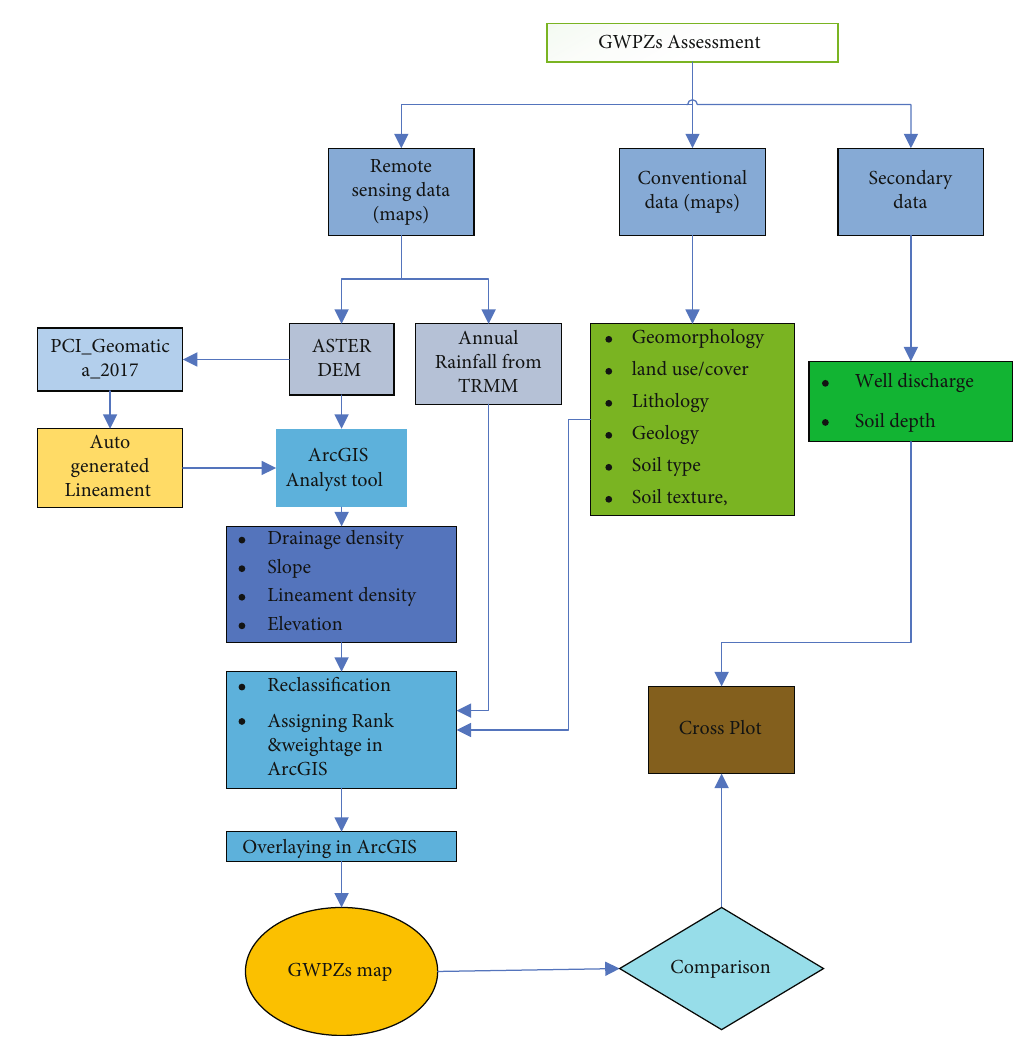
Figure 3: Flowchart indicating assessment of